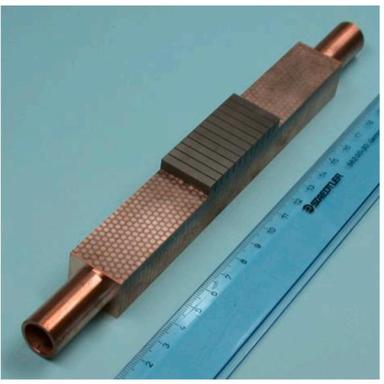
Tungsten flat tile component with additively manufactured heat sink (Cu-infiltrated W-honeycomb structure).